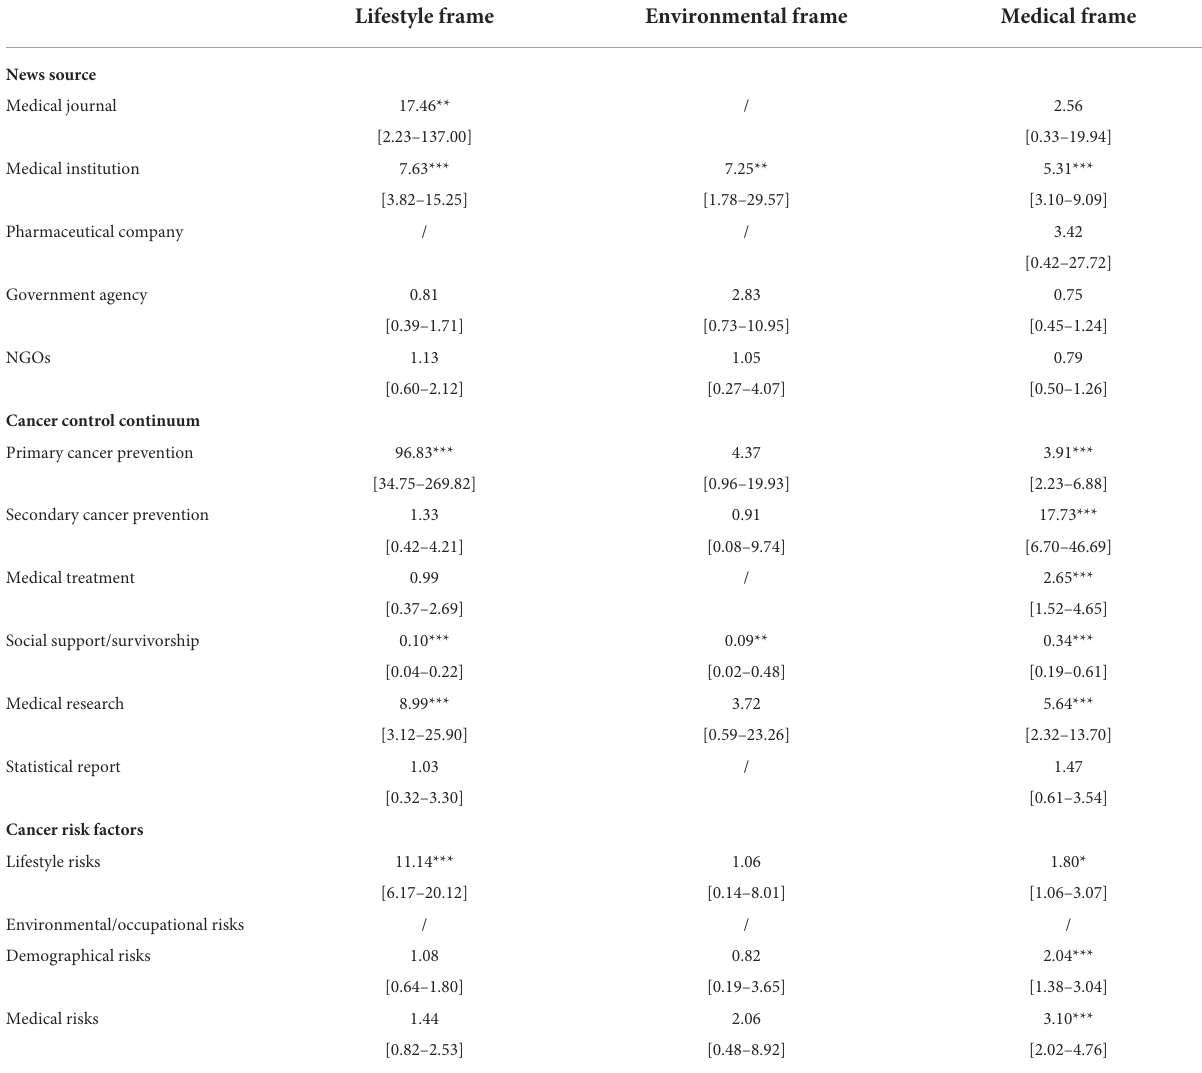
TABLE 2 Multinominal logistic regression analysis: associations between news factors and the portrayal of news frames ( N =